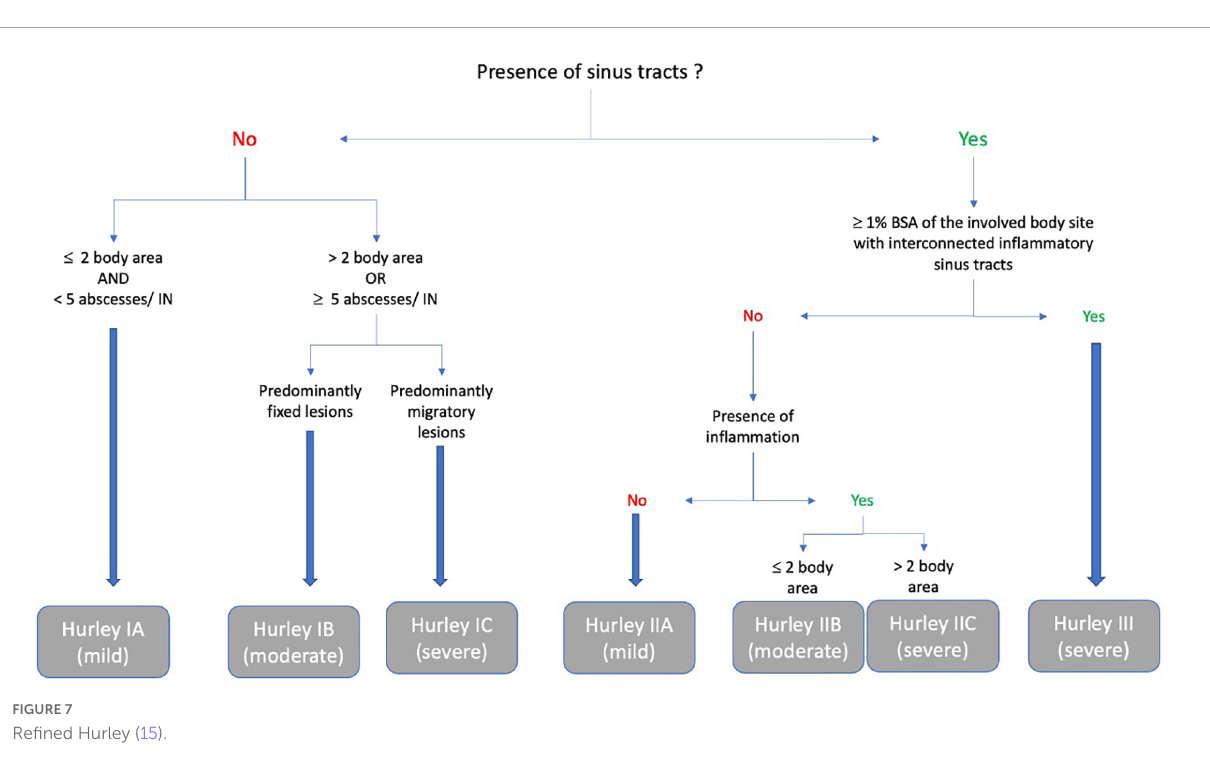
FIGURE7 Refined Hurley